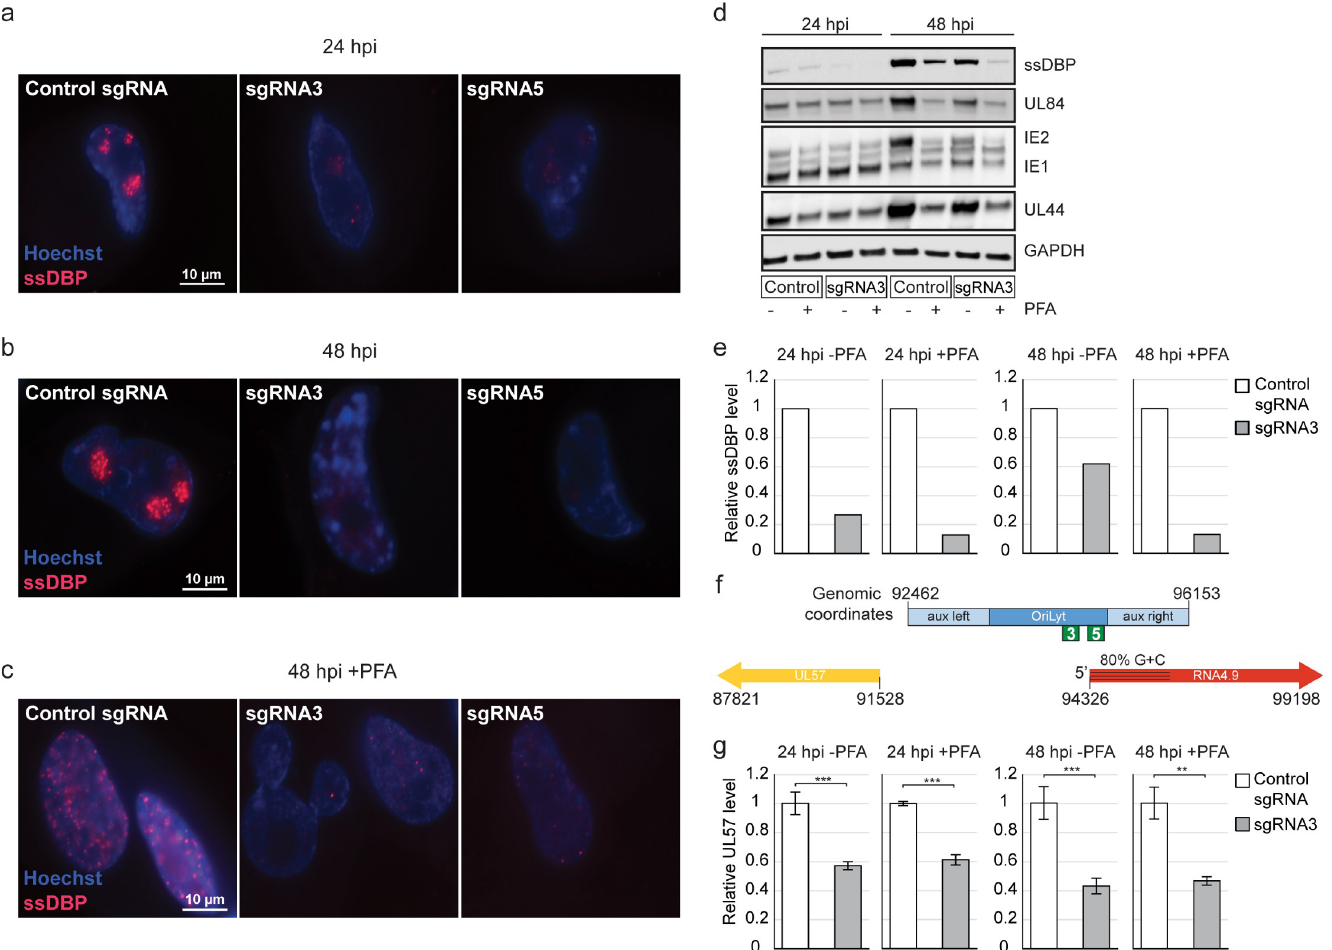
Fig 4. RNA4.9-Cas9 KD substantially reduces ssDBP levels. Fibroblasts expressing CAS9 and either a control sgRNA or a sgRNA targeting RNA4.9 promoter (sgRNA3 or sgRNA5, as indicated) were infected with HCMV Merlin strain (MOI = 3). a) ssDBP (red) was detected by IF at 24 hpi, b) 48 hpi or c) 48 hpi in the presence of PFA. Cells were counterstained with Hoechst (blue). d) ssDBP, IE1/IE2, UL84 and UL44 proteins were detected by immunoblot analysis at 24 or 48 hpi, with and without PFA treatment. GAPDH was used as a loading control. e) Quantification of ssDBP levels from the immunoblot analysis in (d), normalized to the levels of GAPDH. f) Schematic representation of HCMV oriLyt (NC_006273.2), showing the core region (blue) and flanking auxiliary regions (aux, light blue), and genes RNA4.9 (red) and UL57 (yellow). sgRNA PAM sites are indicated in green (sgRNA3–93412 and sgRNA5–93378). g) Relative UL57 levels were quantified using RT-qPCR at 24 and 48 hpi, with and without PFA treatment, and normalized to the cellular ANXA5 transcript. Two-sided t -tests were applied ( ��� p-value < 0.001, �� p- value < 0.01, � p-value < 0.05).